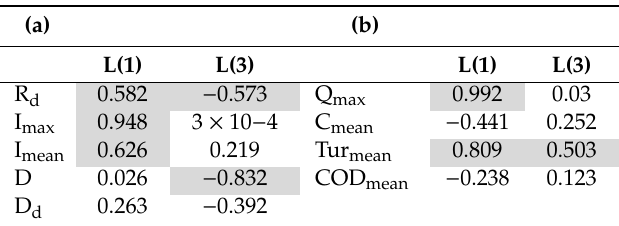
Table 3. Canonical loads ( ρ ) between (a) the explanatory rain variables and (b) response variables, with the significant canonical variables L(1) and L(3) for the El Vado CSO. Values that represent the possible influence of rainfall variables on CSO are highlighted in gray.